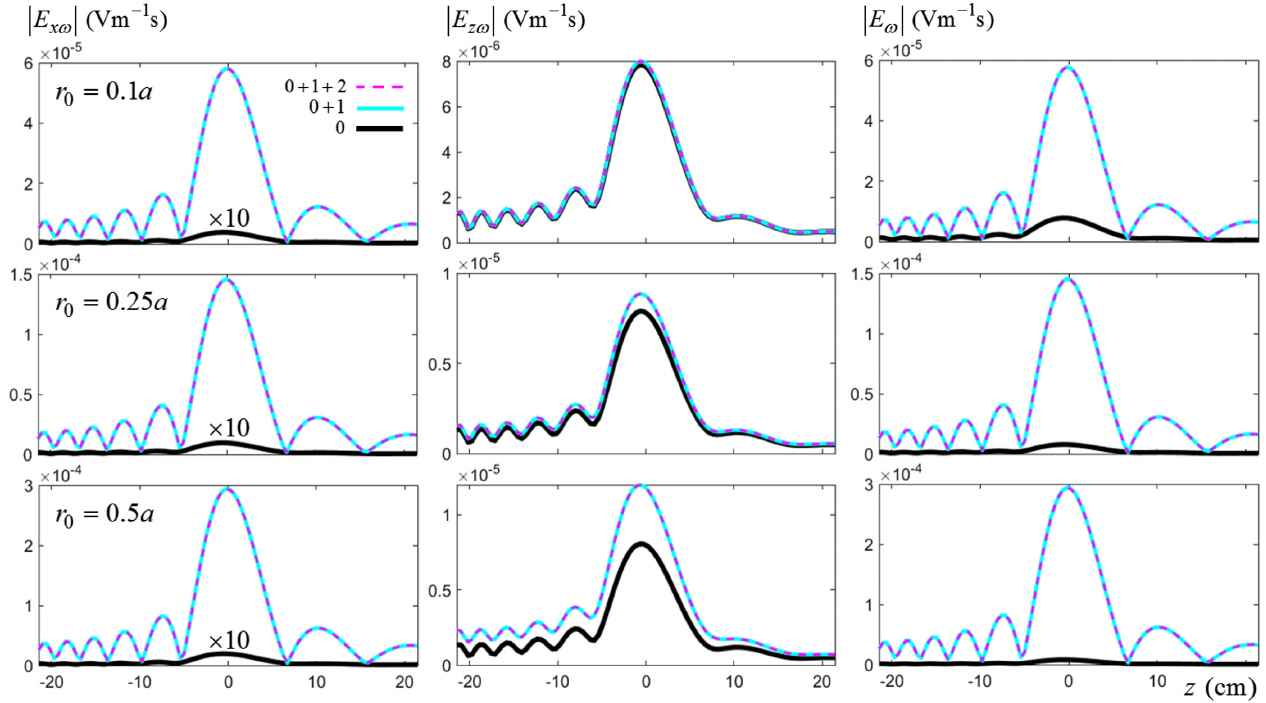
FIG. 2. Field behavior along the line parallel to z -axis and having offset r 0 in x -direction. Black (thickest) line (multiplied by factor 10 in the left column to be recognized from zero) corresponds to the contribution of the term with ν ¼ 0 in Eq. (14). Cyan (thinner) and magenta (dashed) lines correspond to the contribution of two terms (with ν ¼ 0 , 1) and three terms (with ν ¼ 0 , 1, 2), correspondingly, in Eqs. (14) and (15). Top row is for r 0 ¼ a= 10 , middle row is for r 0 ¼ a= 4 , and bottom row is for r 0 ¼ a= 2 . Note that black line on the second plot in the first line is present but partially covered by the other